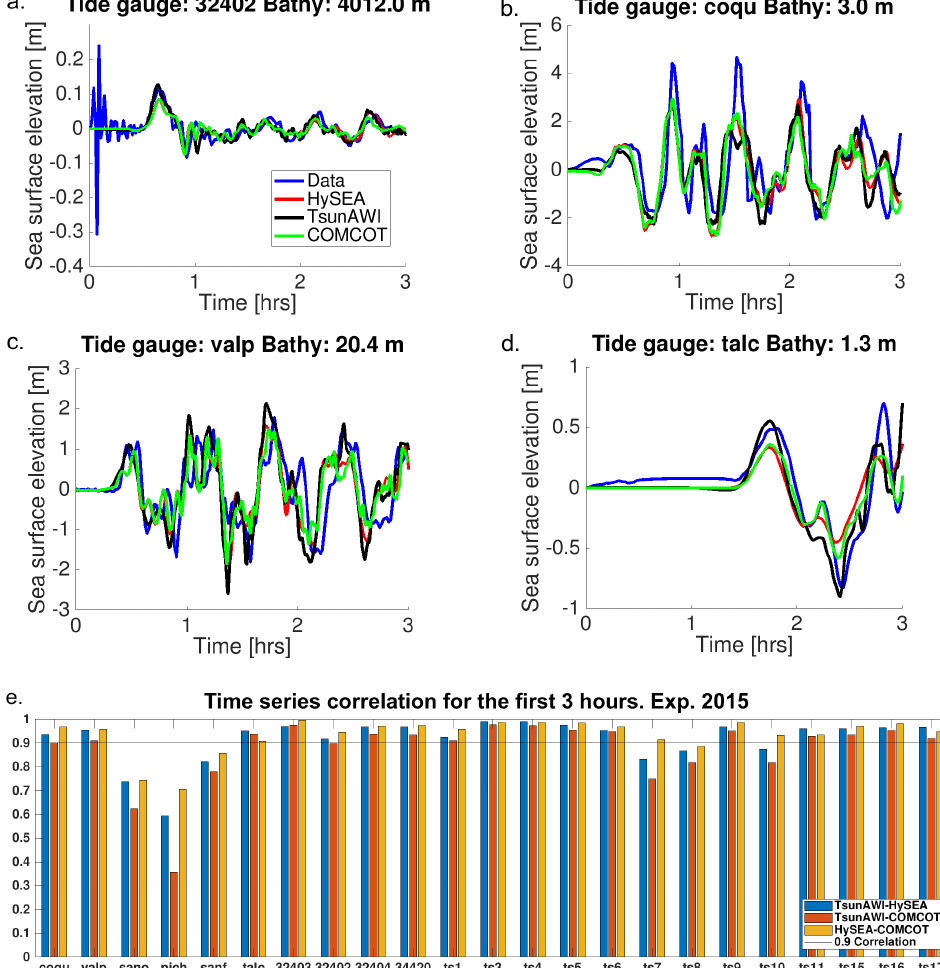
Figure 5. Time series obtained for all models in Experiment 2015, shown for selected forecast points. Results are shown only for Manning n = 0.025. ( a ). Time series results for the DART 32402. ( b ). Time series results for the “coqu” tide gauge. ( c ). Time series results for the “valp” tide gauge. ( d ). Time series results for the “talc” tide gauge. ( e ). Summary of correlations for Experiment 2015 based on a Manning value of n = 0.025. The corresponding correlation values are listed in Table